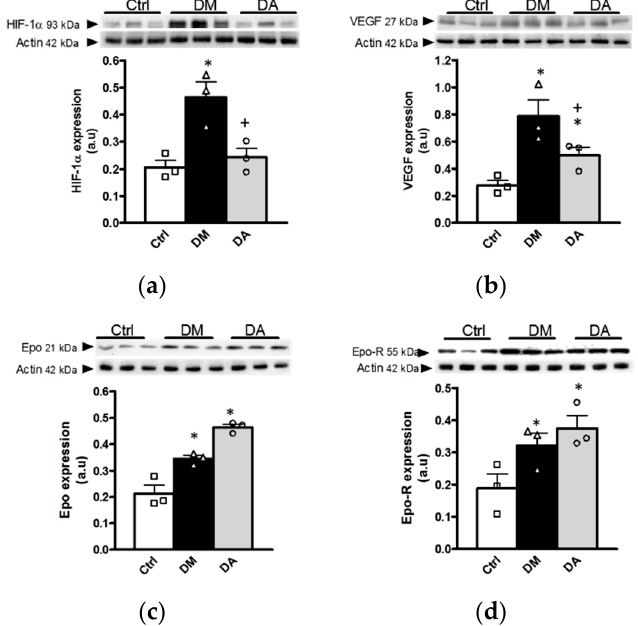
Figure 8. Effects of allicin on hypoxic factors induced by oxidative stress. ( a ) Hypoxia-inducible factor 1-alpha (HIF-1 α ), ( b ) vascular endothelial growth factor (VEGF), ( c ) erythropoietin (Epo), and ( d ) erythropoietin receptor (Epo-R). Ctrl: control; DM: diabetes; DA: diabetes treated with allicin; a.u: arbitrary units. For representative Western blotting, 3 randomly selected samples per group were analyzed. Results are presented as mean ± SEM and analyzed by one-way ANOVA. Statistical significance was established as * p < 0.05 vs. Ctrl, + p < 0.05 vs. DM.